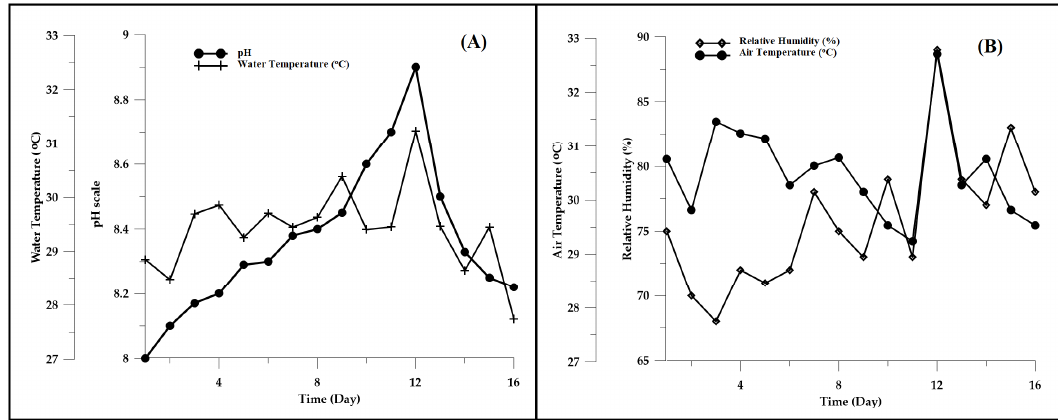
Figure 6. Line plots of ( A ) water quality parameters (water temperature and pH), and ( B ) weather measurements (air temperature and relative humidity) over the 16 ‐ day sampling period.